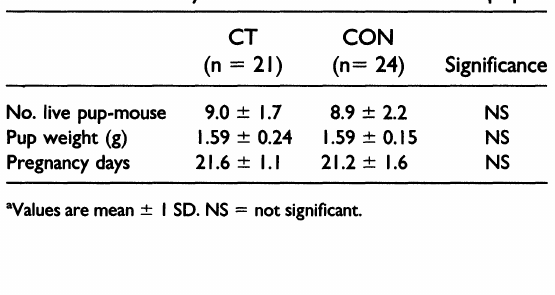
TABLE 2. Delivery data in mice with liveborn pups